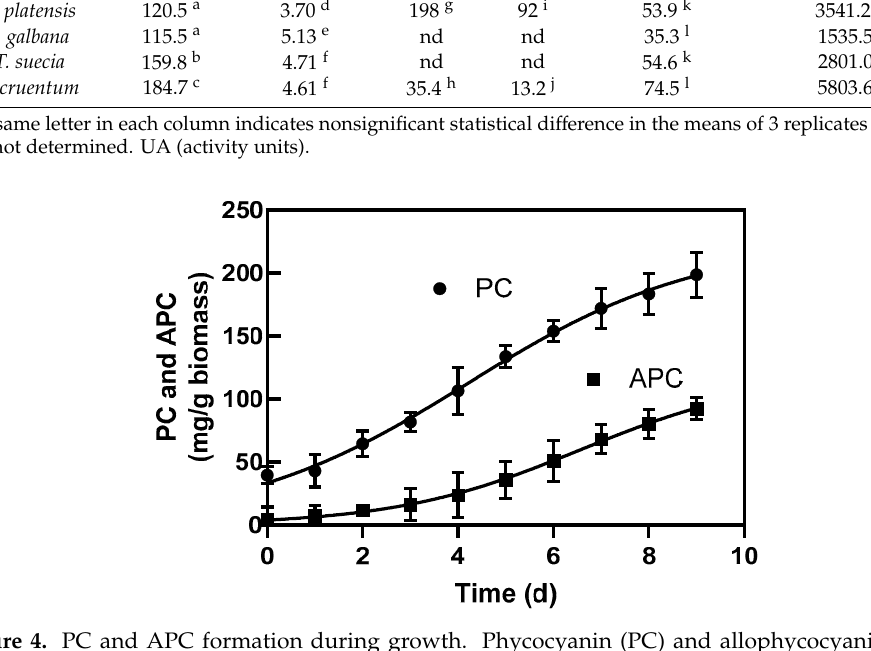
Figure 4. PC and APC formation during growth. Phycocyanin (PC) and allophycocyanin (APC) formation along with the growth of S. platensis in batch cultures supplied a light irradiance of 39.63 kJ d − 1 during 9 days culture.